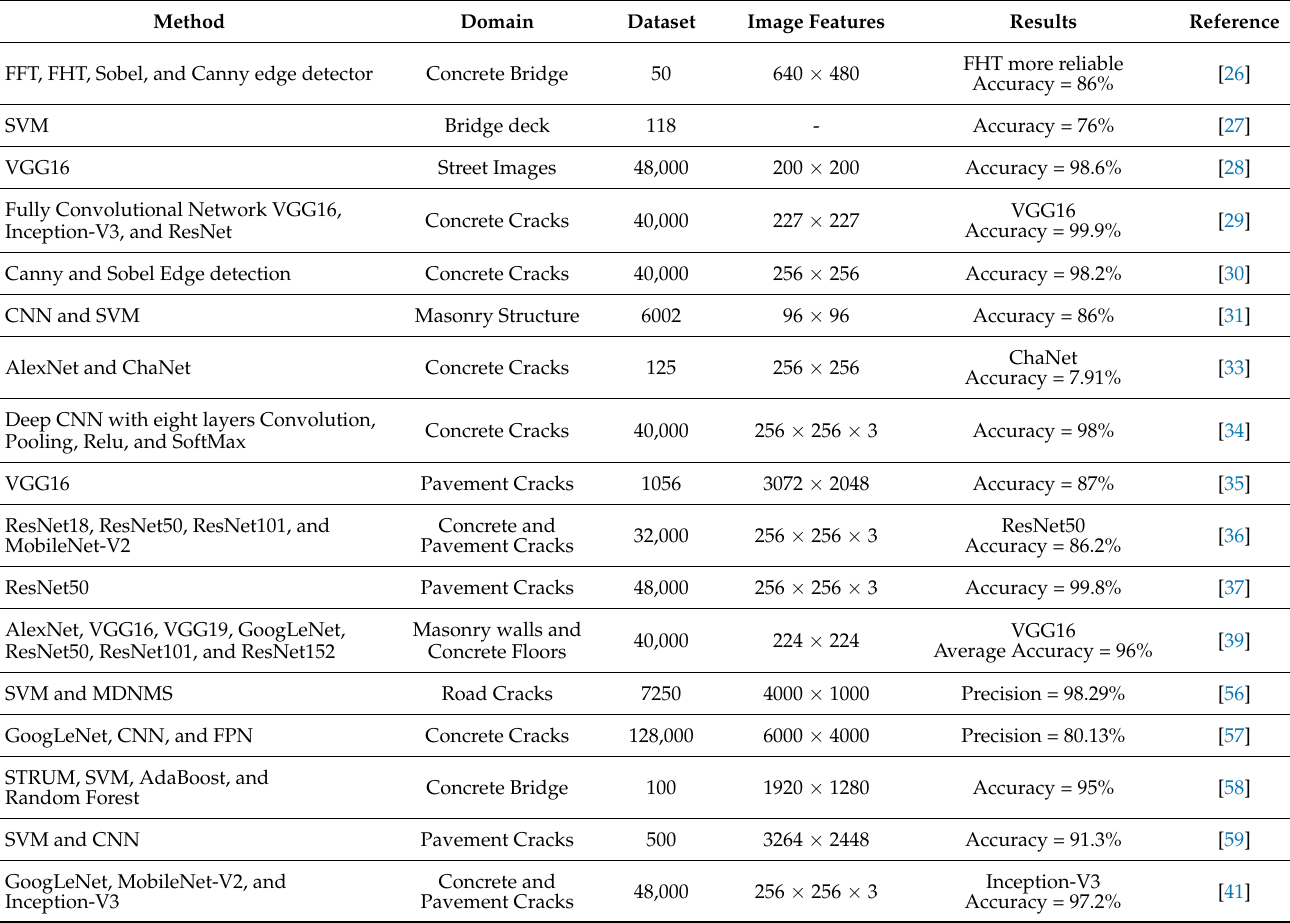
Table 1. Literature